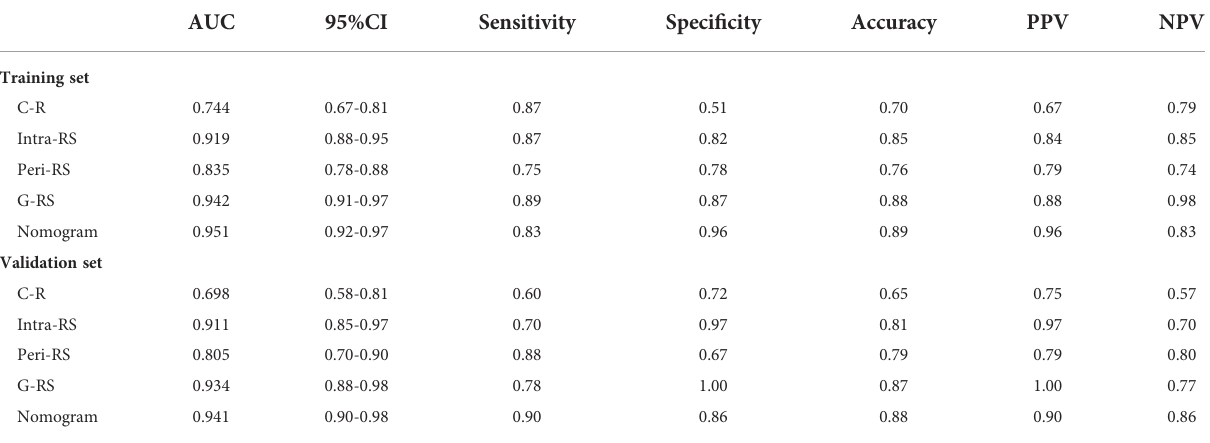
TABLE 3 Prediction performance of the fi ve models in the training and validation